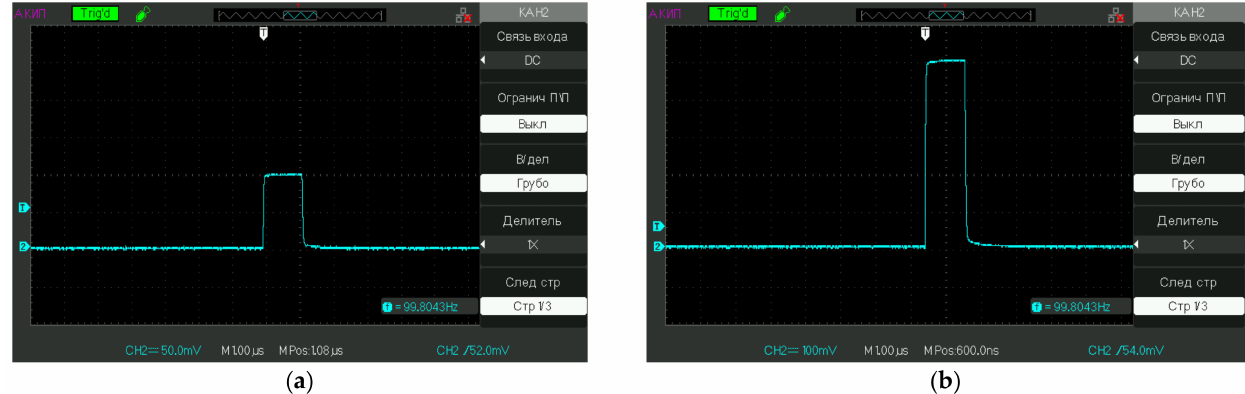
Figure 3. Oscillograms of pulses used in the experiment; the repetition frequency f is indicated in the lower right corner (in this particular case f = 100 Hz). ( a )—100 mV and ( b )—500